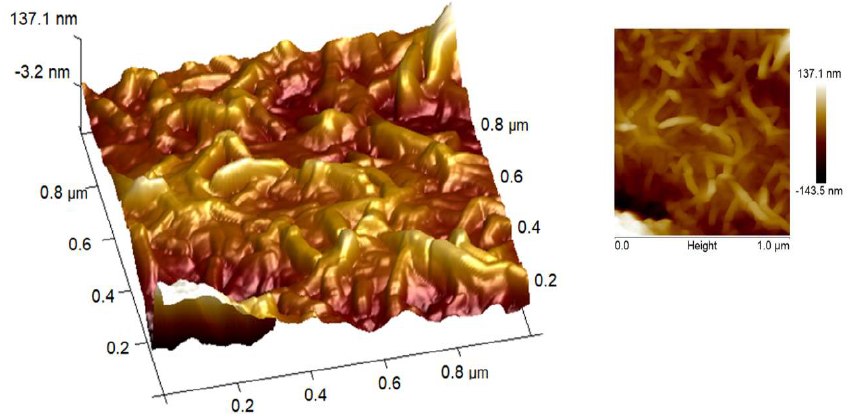
Figure 5. AFM micrographs in HAp/CTs at 1 g/L.